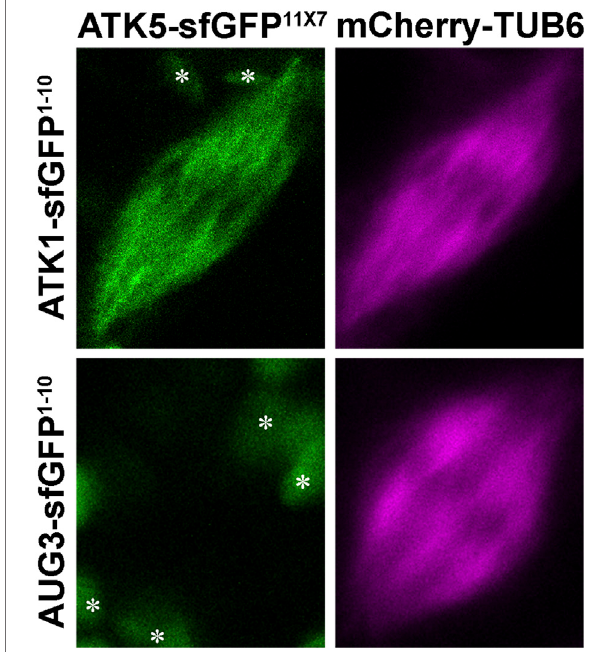
FIGURE7| AssociationofATK1andATK5 invivo in N . benthamiana leaf cells. When leaf cells are induced to enter mitosis with spindle MT arrays marked by mCherry-TUB6, the simultaneous expressions of ATK1-sfGFP 1-10 and ATK5-sfGFP 11X7 resultin thereconstitutionofthe GFPsignal. When AUG3-sfGFP 1-10 and ATK5-sfGFP 11X7 are co-expressed, however, no GFP signal is detected on spindle MTs. The objects (asterisks) in the background are plastids with auto fl